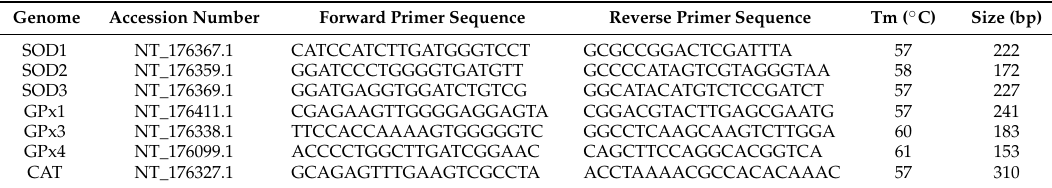
Table 2. Primers used for DNA Methylation